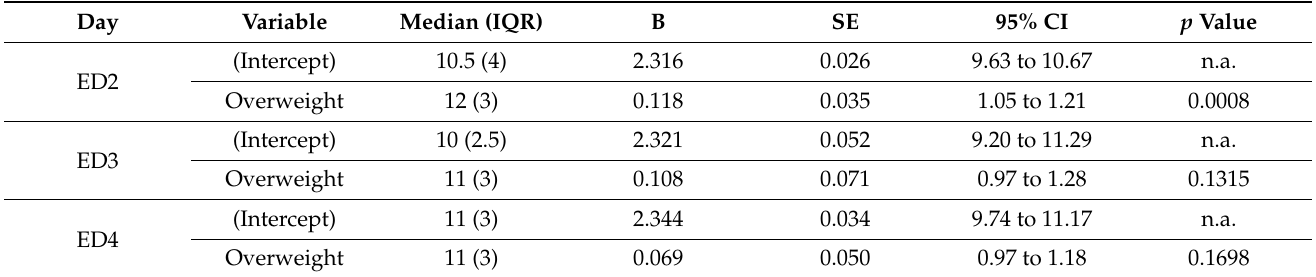
Table 2. Univariate Poisson regression for the number of recovered ova and embryos on embryonic day 2, 3, and 4 in fertilized female mice (with at least one embryo in the reproductive tract).